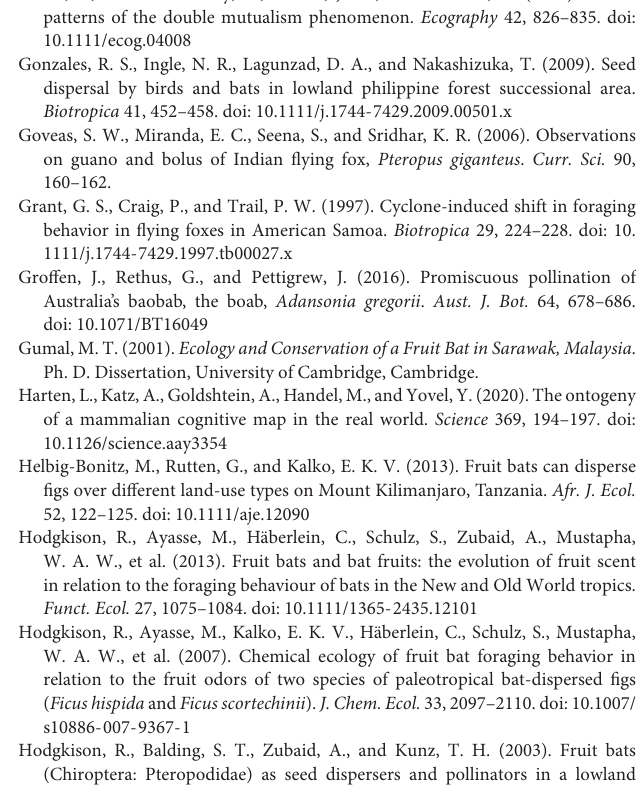
figs over different land-use types on Mount Kilimanjaro, Tanzania. Afr. J. Ecol. 52, 122–125. doi: 10.1111/aje.12090 Hodgkison, R., Ayasse, M., Häberlein, C., Schulz, S., Zubaid, A., Mustapha, W. A. W., et al. (2013). Fruit bats and bat fruits: the evolution of fruit scent in relation to the foraging behaviour of bats in the New and Old World tropics. Funct. Ecol. 27, 1075–1084. doi: 10.1111/1365-2435.12101 Hodgkison, R., Ayasse, M., Kalko, E. K. V., Häberlein, C., Schulz, S., Mustapha, W. A. W., et al. (2007). Chemical ecology of fruit bat foraging behavior in relation to the fruit odors of two species of paleotropical bat-dispersed figs ( Ficushispida and Ficusscortechinii ). J.Chem.Ecol. 33,2097–2110.doi:10.1007/